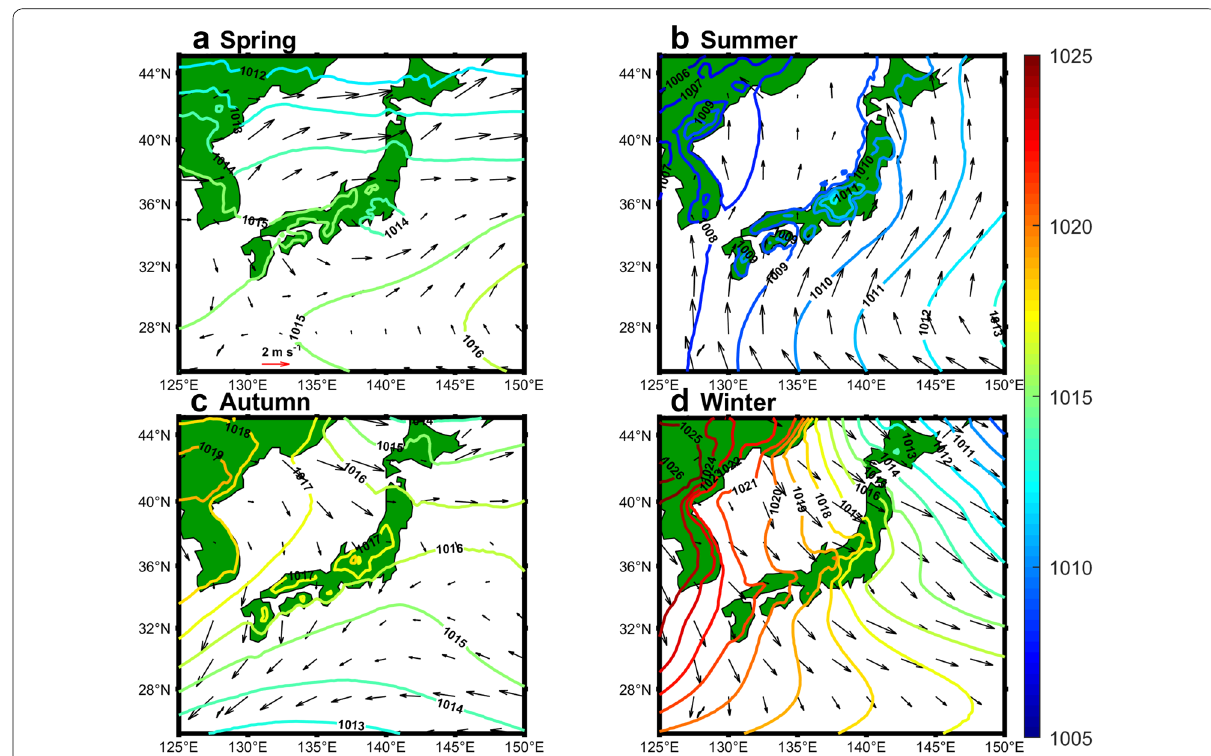
Fig. 3 The map of 10-m wind field (vectors, m s − 1 ) and sea surface level pressure (contours,